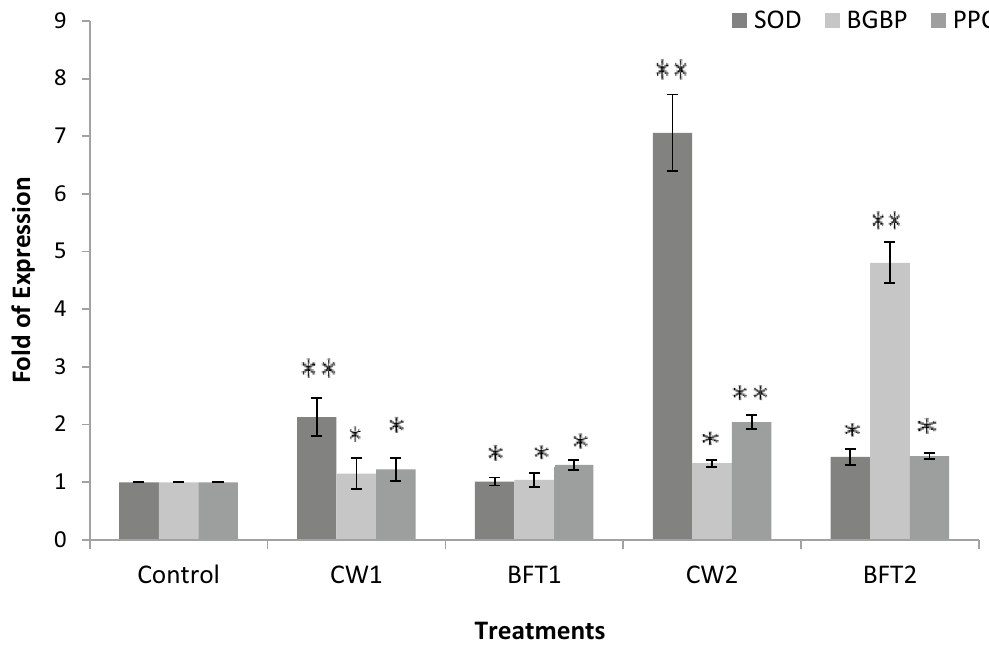
Figure 5. Relative expression of SOD, β-glucan binding protein and prophenol oxidase of P. indicus cultured in different treatments and error bar showing standard deviation of three replicates. Significance between different groups ( P < 0.05) marked with